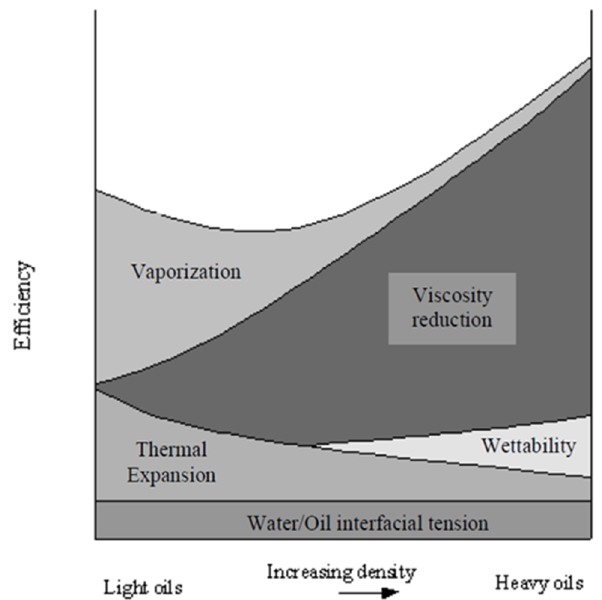
Figure 1. Contributions of different mechanisms to improving oil recovery by a heated fluid Used with permission from [22] Editions Technip: Paris, France.